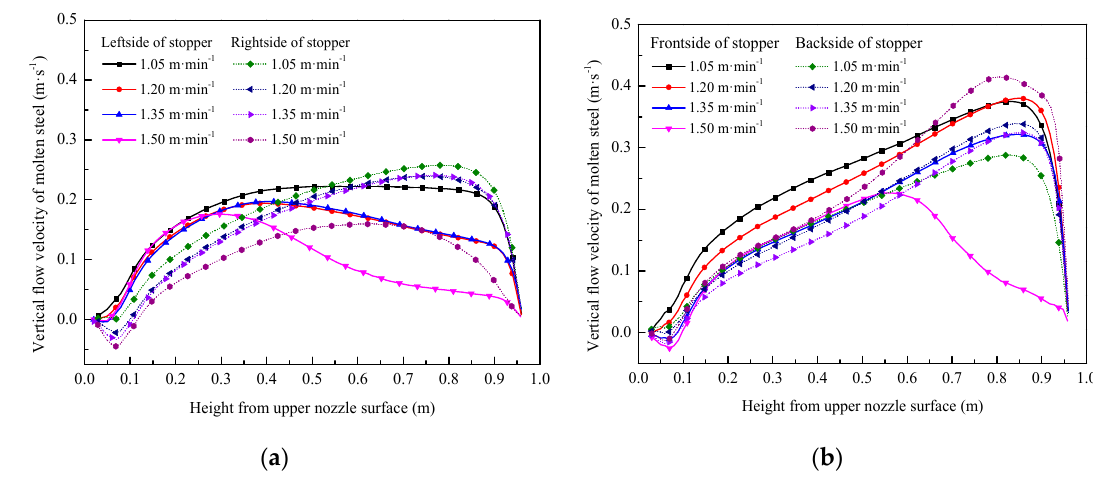
Figure 11. Vertical velocity of liquid steel in near area of stopper at different casting speeds: ( a ) left and right sides of the stopper; ( b ) front and back sides of the stopper.